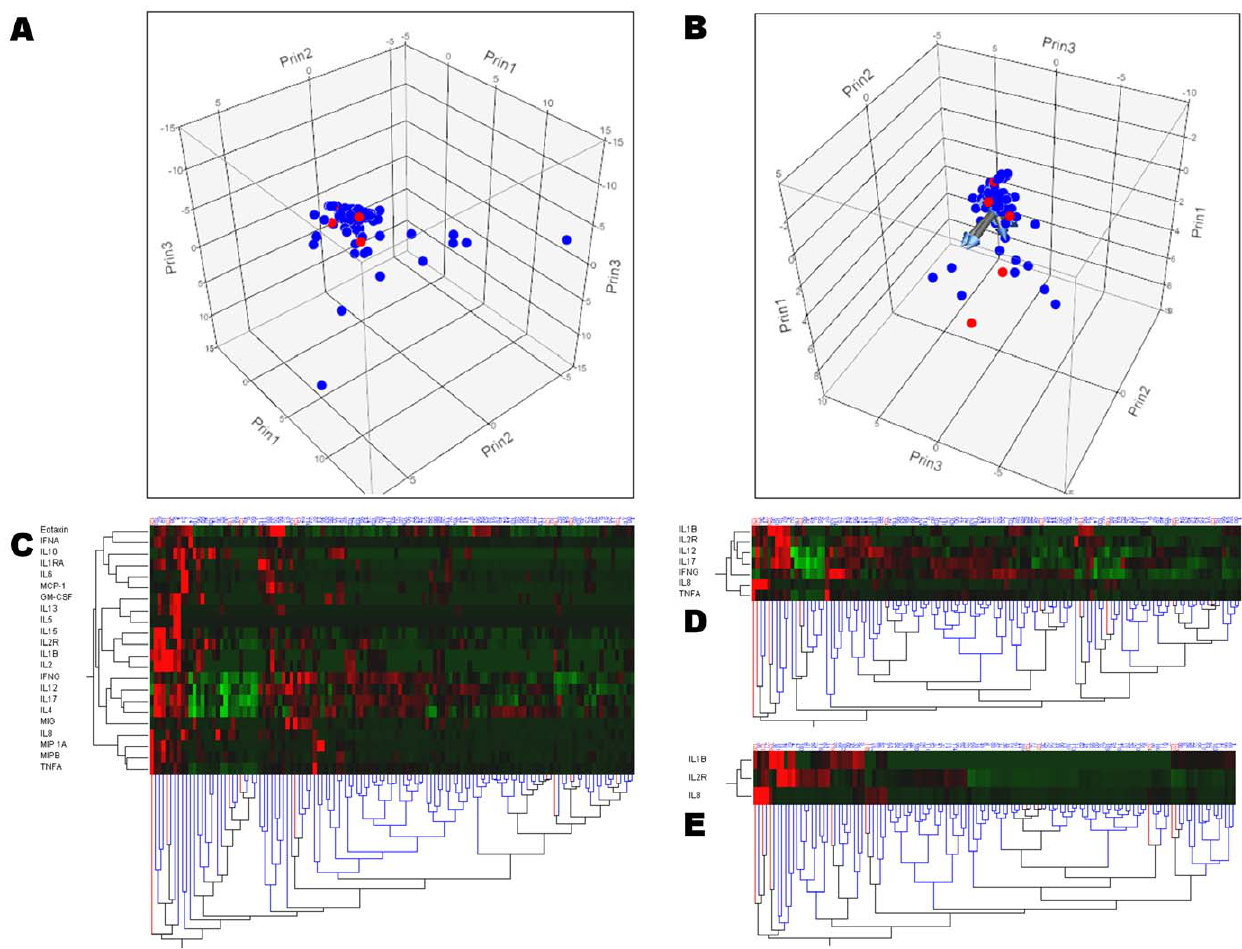
Figure 3. Principal component analysis and clustering of cytokine profiles in patients with (n=10) and without (n=116) septic shock. Patients with (red dots) and without (blue dots) septic shock are represented according to the first three components computed using principal component analysis of either all 22 cytokines (panel A), or using only IFN c , sIL-2R, IL-1 b , IL-12, IL-17, IL-8 and TNF a (panel B). Hierarchical cluster analysis using all 22 cytokines measured (panel C) and more limited profiles only based on IFN c , sIL-2R, IL-1 b , IL-12, IL-17, IL-8 and TNF a (panel D) or sIL-2R, IL-1 b , and IL-8 (panel E) are also presented. The dendrogram at the bottom of panels C, D & E shows the clustering of patients with (red lines) and without (blues lines) septic shock, according to the cytokine profile selected (dendrodram at the left). The color map at the center indicates the cytokine levels for each patient (brightest green is lowest level and brightest red is highest level measured). Altogether, these analyses show patients with septic shock cannot be distinguished from those